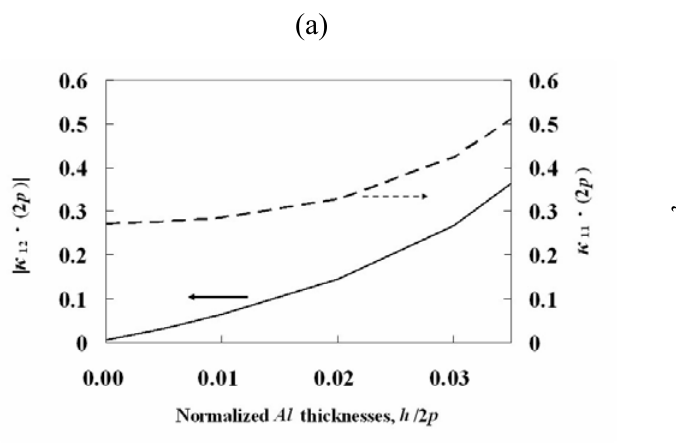
Figure 4. The COM parameters under the Al periodic grating on ST-cut quartz: (a) | κ ·2 p and (b) and κ 11